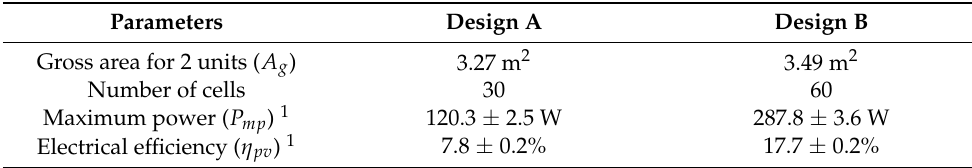
Figure 18. Design A cross-sectional view [18]. Table 10. Collector A and B